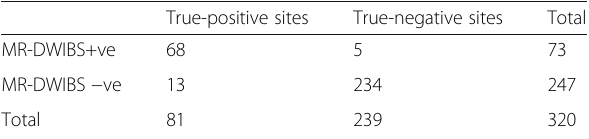
Table 4 F-FDG-PET/CT and WB-MR/DWIBS staging accuracy in correlation with the reference staging 18-FDG PET/CT